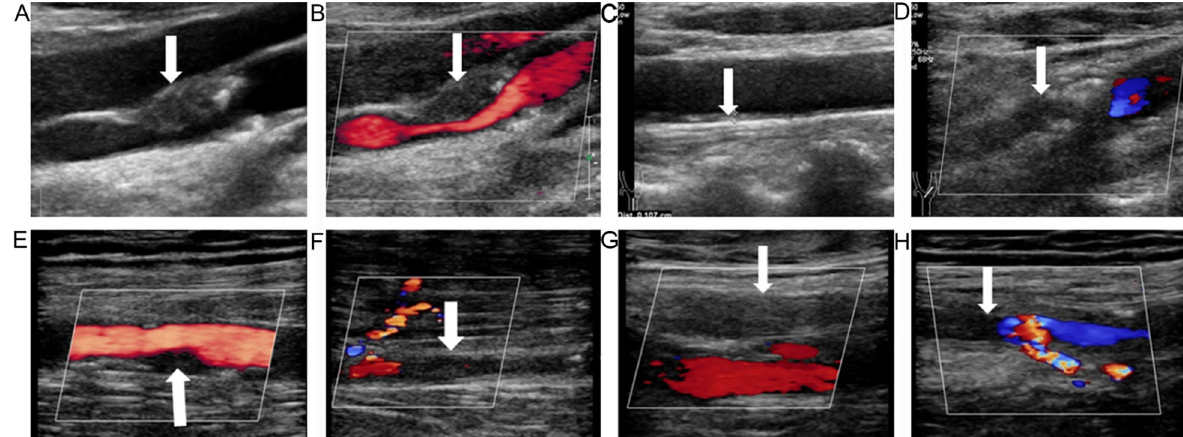
Figure 1. Ultrasonography of the carotid and lower limb arteries of a 74-year-old male patient with diabetic foot, peripheral arterial disease, and plaques in both internal carotid arteries. A , High-resolution gray-scale sonography revealed a plaque (arrow) in the front wall of the right internal carotid artery, and C , an increase in the intima-media thickness of the left common carotid artery (arrow; the measured value was 1.07 cm). B , Color Doppler ultrasound showed severe stenosis of the lumen of the right internal carotid artery (arrow; the diameter was reduced by 70 – 99%), D , indicated that the left internal carotid artery was occluded (arrow), E , moderate stenosis of the right super fi cial femoral artery (arrow; the diameter was reduced by 50 – 99%), F , segmental occlusion in the anterior tibial artery (arrow) along with a collateral artery, G , occlusion of the left super fi cial femoral artery (arrow), and H , occlusion of the left super fi cial femoral artery (arrow) accompanied by a collateral artery. The overall ultrasonic score was 10 points for the right lower limb and 9 points for the left lower